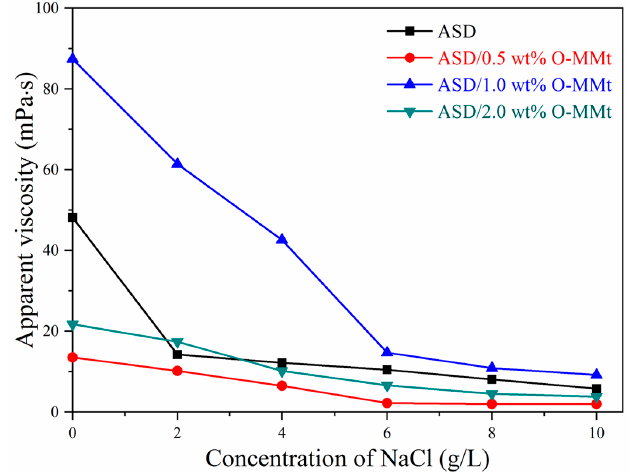
Figure 13. Relationships between the apparent viscosities of ASD, ASD/0.5 wt% O-MMt, ASD/1.0 wt% O-MMt, ASD/2.0 wt% O-MMt, and NaCl